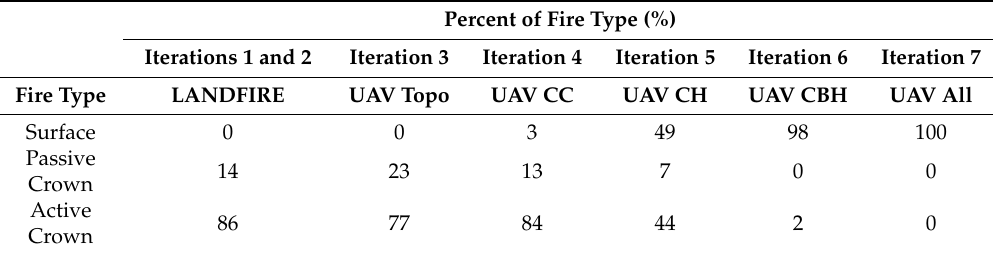
Table 5. Crown fire behavior model outputs for each iteration. Inputs for Iteration 1 included the original data layers from the LANDFIRE database in 30 m resolution. Iteration 2 used the resampled LANDFIRE data in 10 m resolution. Iteration 3 used UAV-derived elevation, slope, and aspect rasters with LANDFIRE data as other inputs. Iteration 4 substituted UAV-derived canopy cover with LANDFIRE data for all other inputs. Iteration 5 included the UAV-derived canopy height estimate with LANDFIRE data for other inputs. Iteration 6 used the UAV-derived canopy base height estimate along with all other LANDFIRE data inputs. Iteration 7 included UAV-derived topography, canopy cover, canopy height, and canopy base